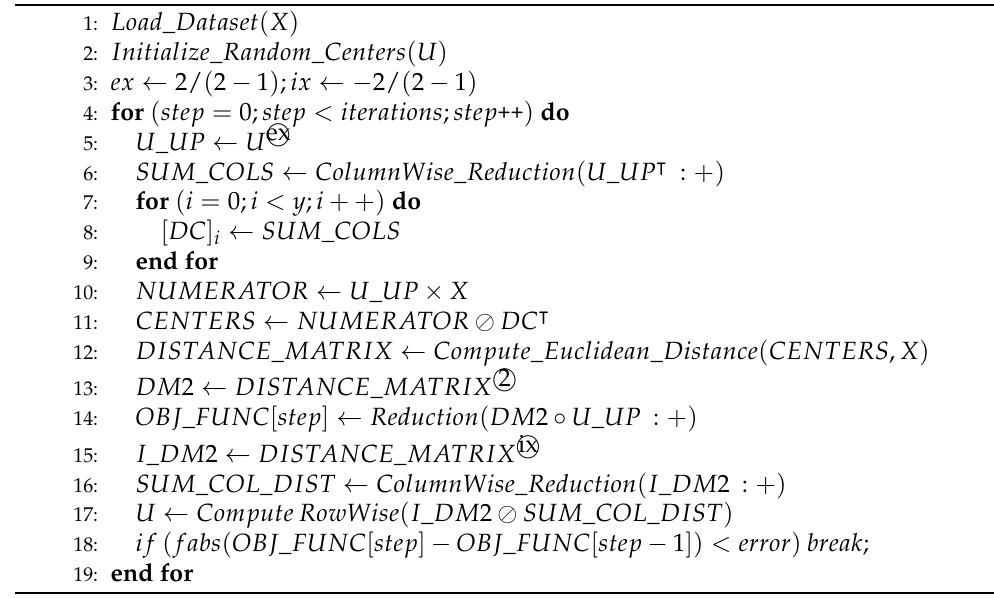
Algorithm 1: Pseudocode for the main loop of the FCM